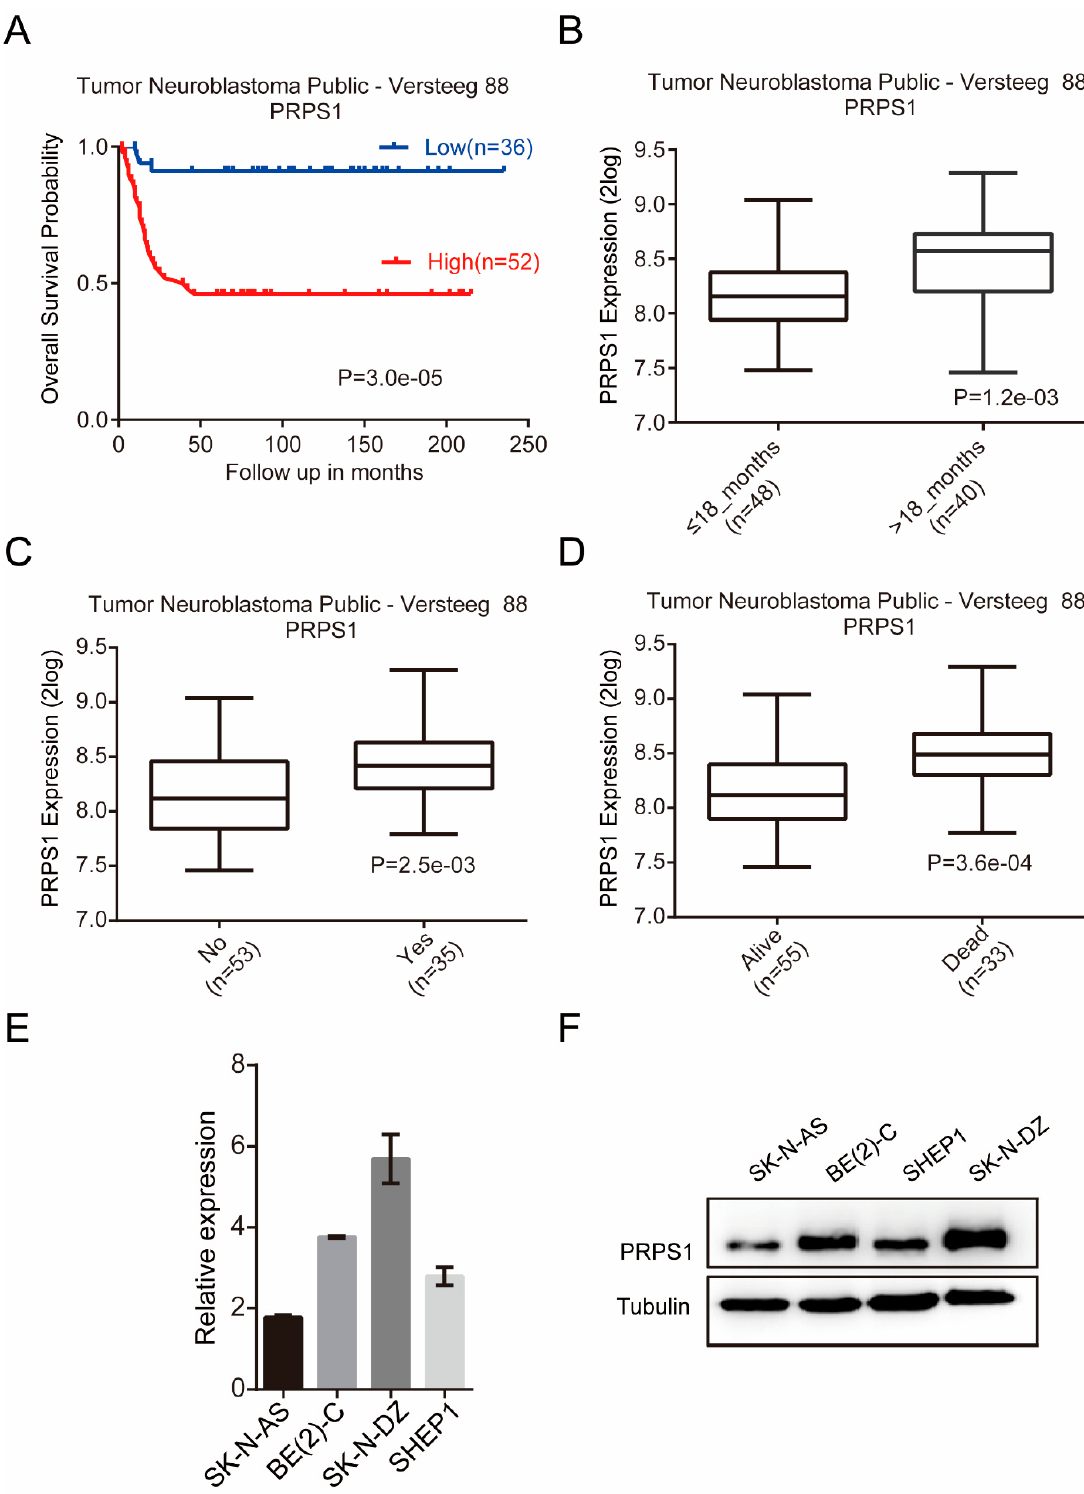
Figure 1. High expression of phosphoribosyl pyrophosphate synthetase 1 (PRPS1) predicts poor prognosis of patients with neuroblastoma and is commonly expressed in neuroblastoma cells. ( A ) The relationship between PRPS1 expression and the overall survival probability, based on data from the Tumor Neuroblastoma Public-Versteeg 88 database within the R2 platform. ( B ) The expression of PRPS1 among different age groups using data from the Tumor Neuroblastoma Public-Versteeg 88 database. ( C ) The expression of PRPS1 in recurrent and non-recurrent patients using data from the Tumor Neuroblastoma Public-Versteeg 88 database. ( D ) The expression of PRPS1 in live or dead